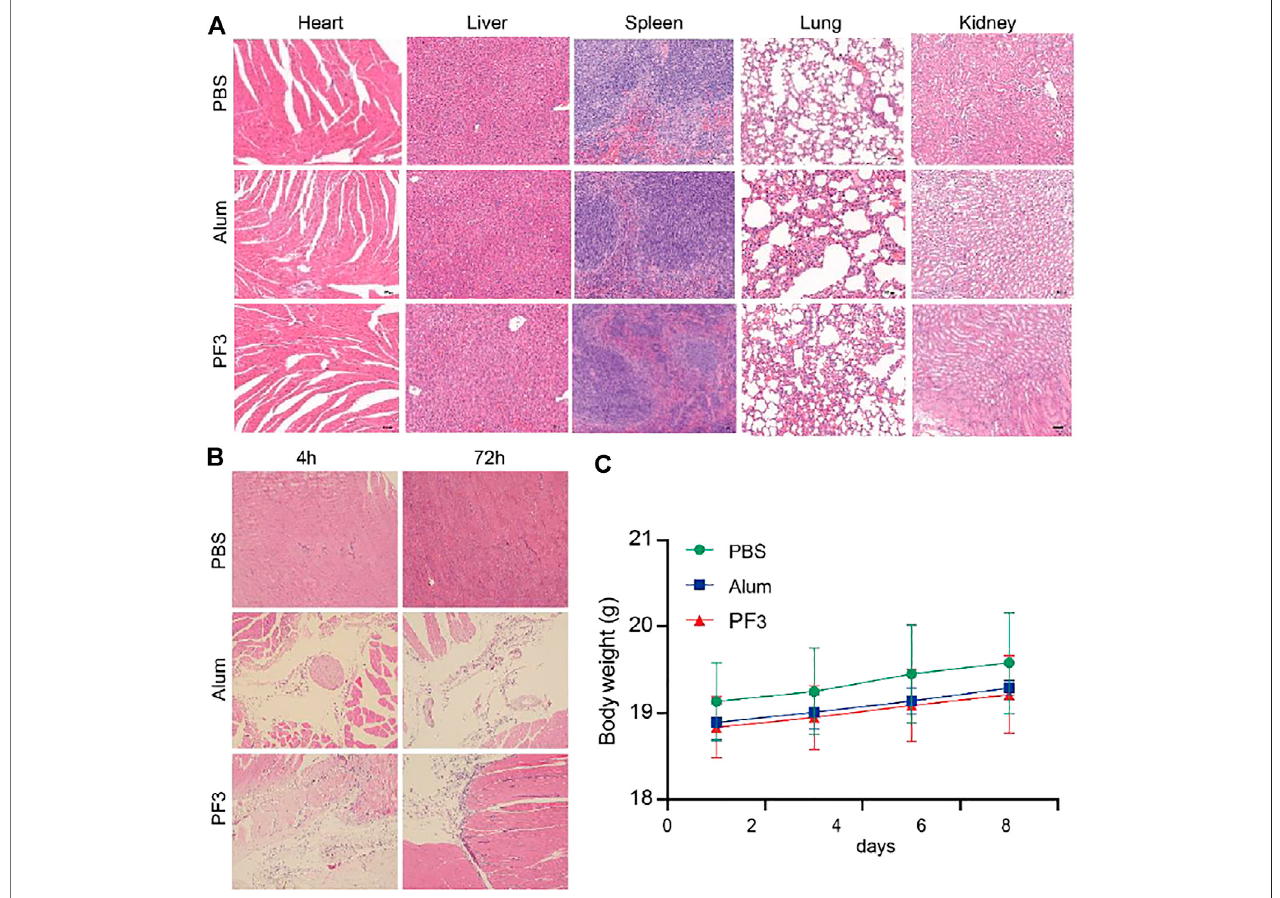
FIGURE3| PF3isSafeinMice. (A) RepresentativeimagesofbiocompatibilityevaluationsviaH&Estainingofvitalorgansections.Scalebarrepresents100 µm. (B) HE staining of muscle at different time after intramuscular injection. (C) Change of the body weight of BALB/c mice (n = 3).